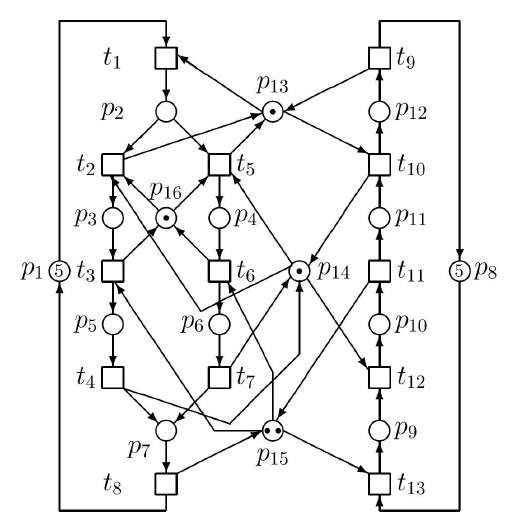
Figure 5. The bigger PN